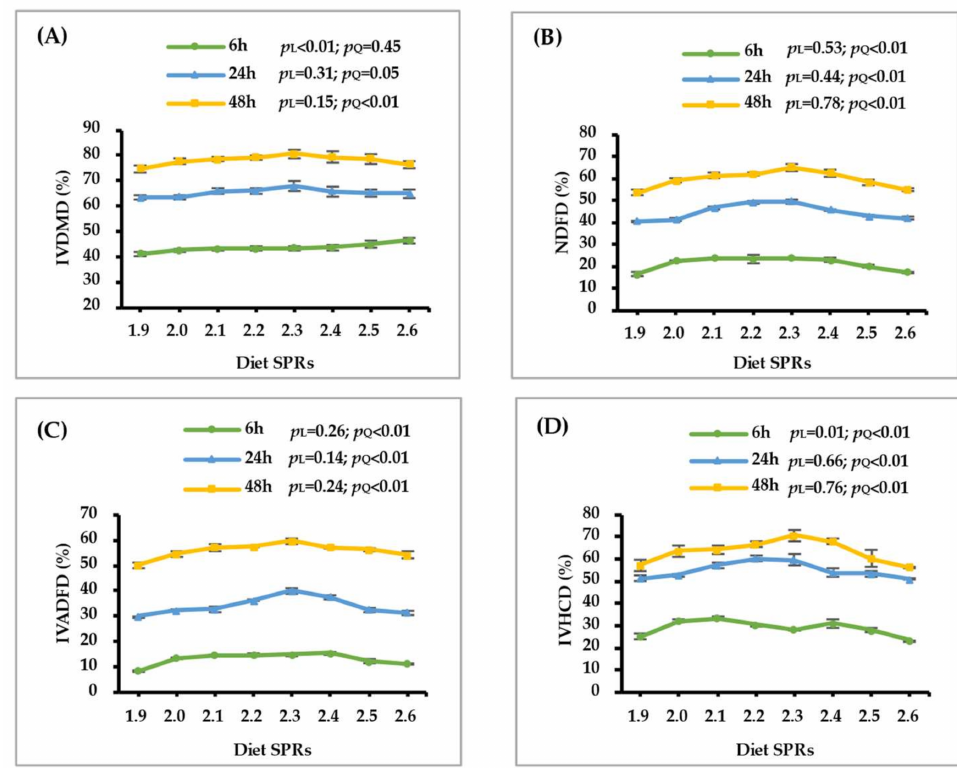
Figure 1. Effect of dietary rumen-degradable starch to rumen-degradable protein ratio (SPR) on in vitro dry matte disappearance (IVDMD, ( A ), in vitro neutral detergent fiber disappearance (IVNDFD, ( B )), in vitro acid detergent fiber disappearance (IVADFD, ( C ), and in vitro hemicellulose disappearance (IVHCD, ( D )) after 6, 24, and 48 h of incubation. Error bars indicate measure of variation within the dietary SPRs. L is linear, and Q is quadratic effects for diet